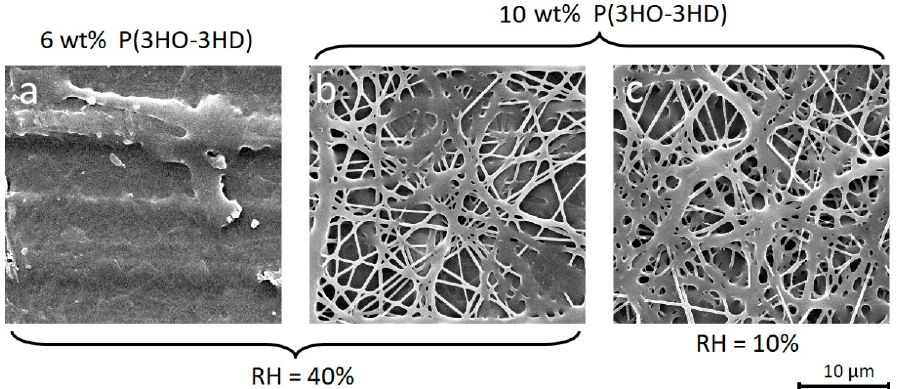
Figure 2. SEM images of P(3HO- co -3HD) nanofibers that were electrospun from a solution with 30% anisole, 35% acetone and 35% ether at 25 °C. While a sufficient polymer concentration is critical to avoid film formation by fused nanofibers ( a , b ), the effect of the relative humidity is less pronounced ( b , c ).